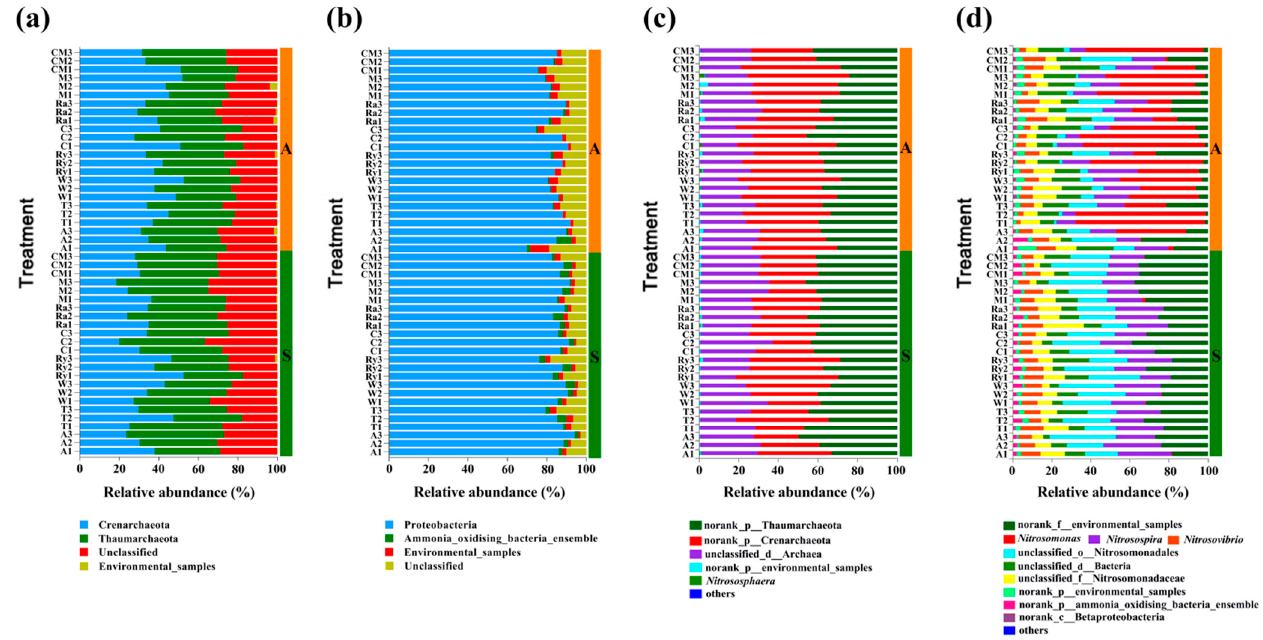
Figure 5. Changes in the relative abundance at phyla ( a , b ) and genus ( c , d ) levels of AOA and AOB in different treatments in spring (S) and autumn (A). A—alfalfa; T—trifolium; W—wheat; Ry—rye; C—chrysanthemum; Ra—rape; M—mustard; CM—cucumber monoculture.